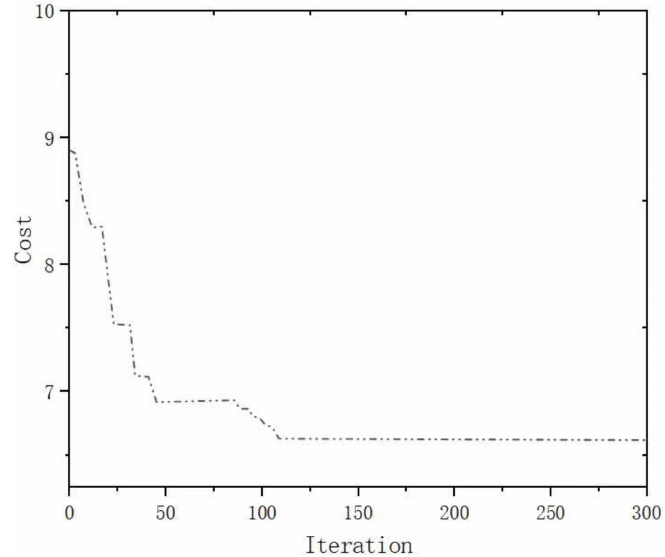
Figure 8. Cost iteration convergence graph for blank dimension